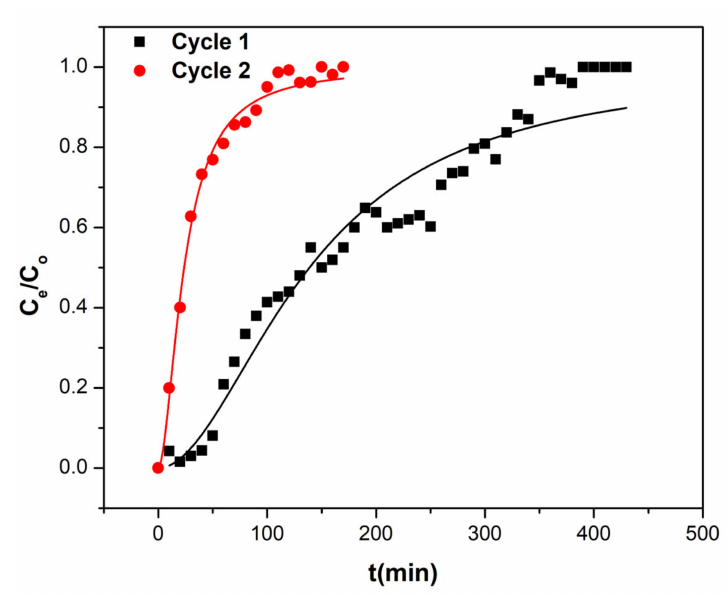
Figure 14. Nonlinear fit of Yan et al. model for adsorption of MO by (1). (0.5 g of (1) packed in column, 100 mg/L of MO dye, 1 mL/min flow